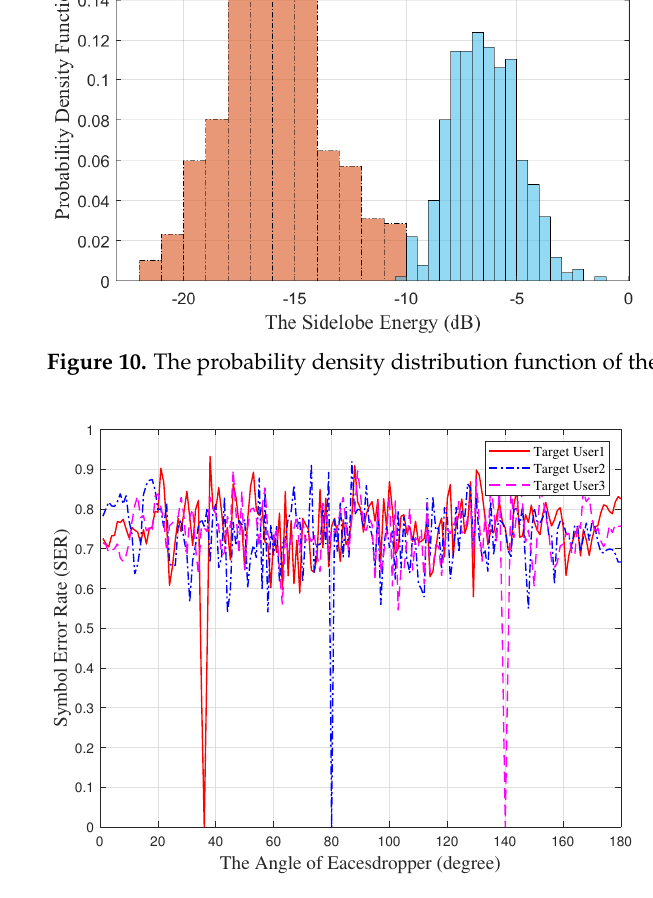
Figure 11. The symbol error rate against the angle of the eavesdropper.